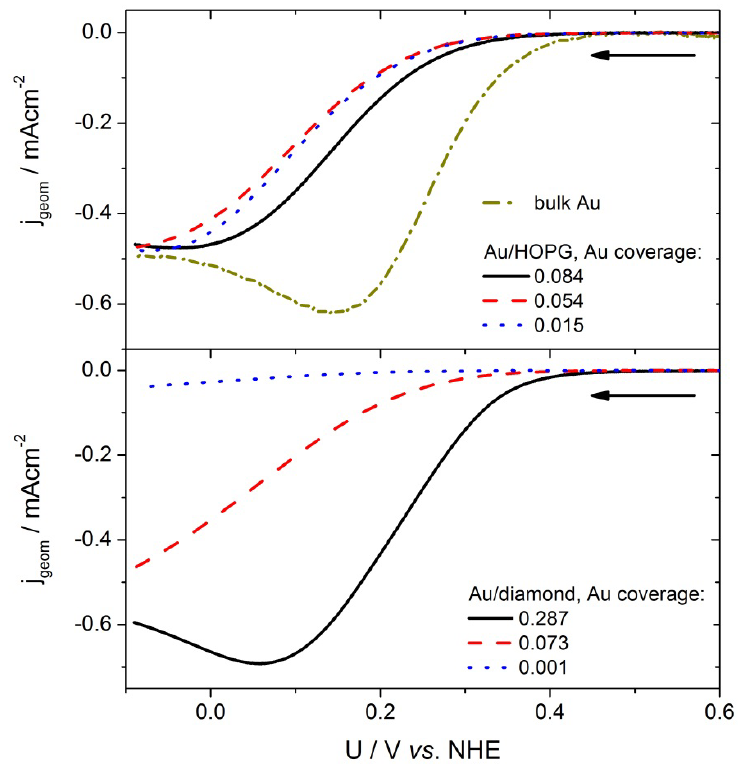
Figure 5. Current-voltage curves of different Au/HOPG and Au/diamond samples as well as the gold bulk sample with decreasing potential in O 100 mV/s, the arrows indicate the direction of the potential